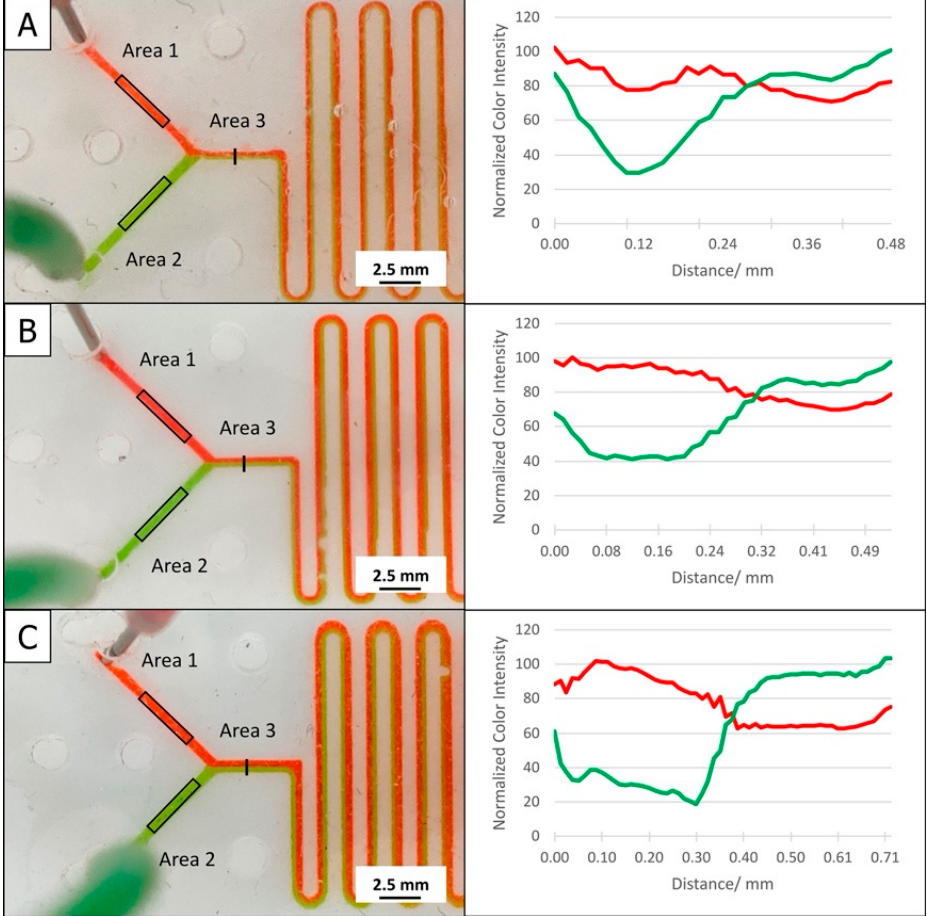
Figure 5. Close ‐ up photographs of assembled microfluidic device with the serpentine mixer microchannel fabricated by ( A ) D-3D FDM, ( B ) D-CNC, and ( C ) M-CNC. The three device configurations were tested under colored liquid flow at 50 µ L/min Laminar flow of the two fluids is obvious as they merge at the Y-junctions. The graphs to the right show cross-sectional profiles of the color intensity at area 3. The profiles were constructed with the normalized color intensities, calculated by taking the color intensity value in area 3 divided by baseline color intensity from area 1 (red) or area 2 (green) multiplied by 100 and plotted against the location in the channel (top wall considered to be 0).